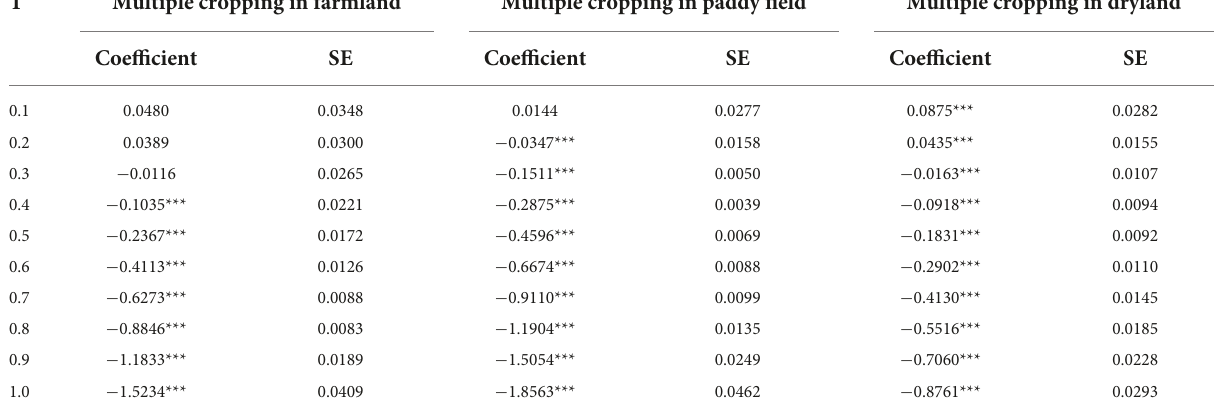
TABLE 6 Generalized propensity score matching treatment effect estimation